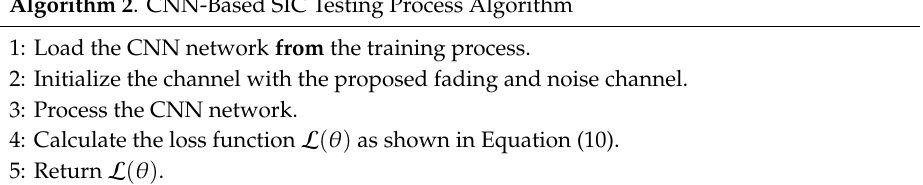
Algorithm 2 . CNN-Based SIC Testing Process